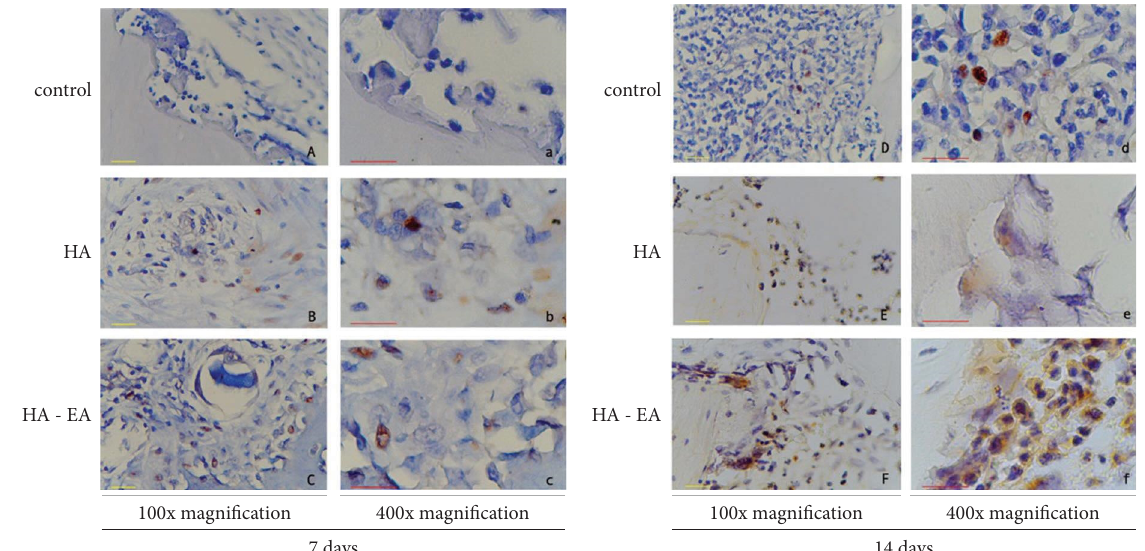
Figure 3: IL-10 expression in bone tissue 7 days after application (a, b, and c) and 14 days after application (d, e, and f). Te IL-10 expression was expressed in macrophages as brown colour in